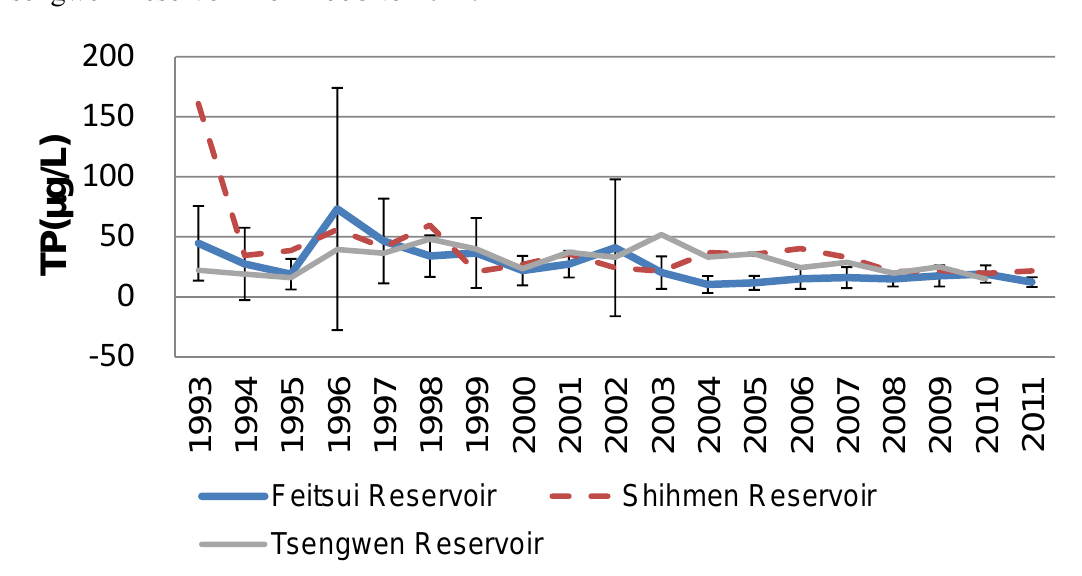
Figure 2. Water Quality Variations of Feitsui Reservoir, Shihmen Reservoir, and Tsengwen Reservoir from 1993 to